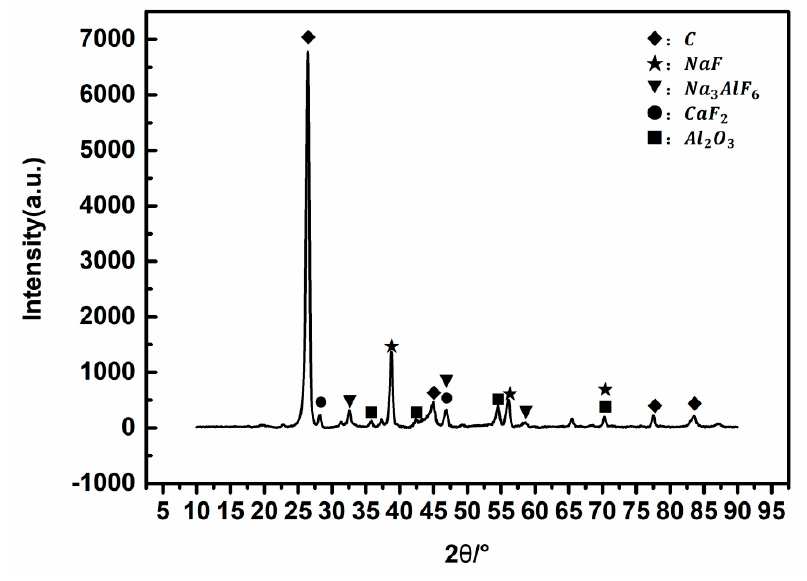
Figure 1. XRD pattern image of Spent Pot Lining First Cut (SPL-1cut).